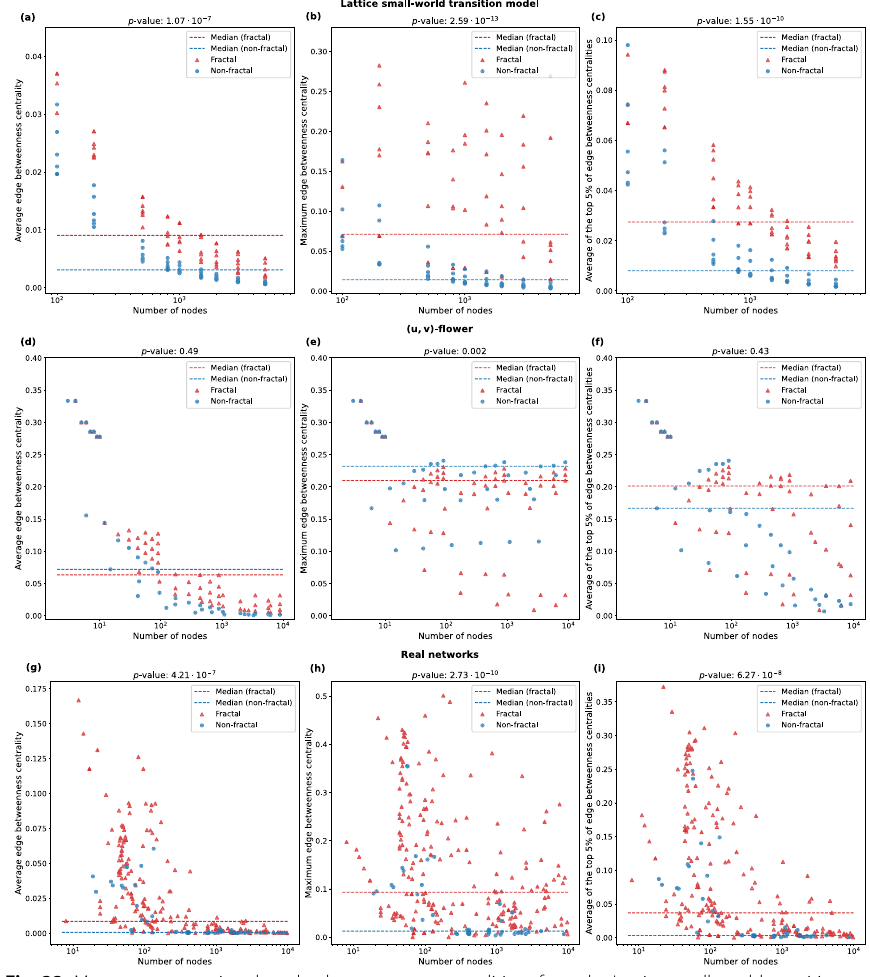
Fig. 22 Measures concerning the edge betweenness centralities of a – c the Lattice small‑world transition model, d – f the ( u , v )‑flower, g – i the real networks. a , d , g Average edge betweenness centrality; b , e , h maximum edge betweenness centrality; c , f , i average of the top 5% of edge betweenness centralities plotted against the logarithm of the number of nodes. The p ‑values in the title of each subfigure correspond to the Mann–Whitney U rank test performed on the corresponding metric values to see the statistical significance of the difference in the distribution of fractal and non‑fractal